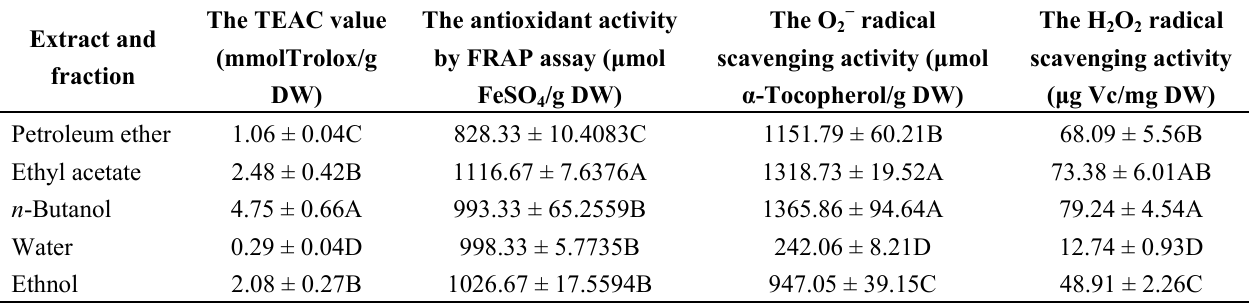
Table 2. The performances of the antioxidant activities, the O scavenging